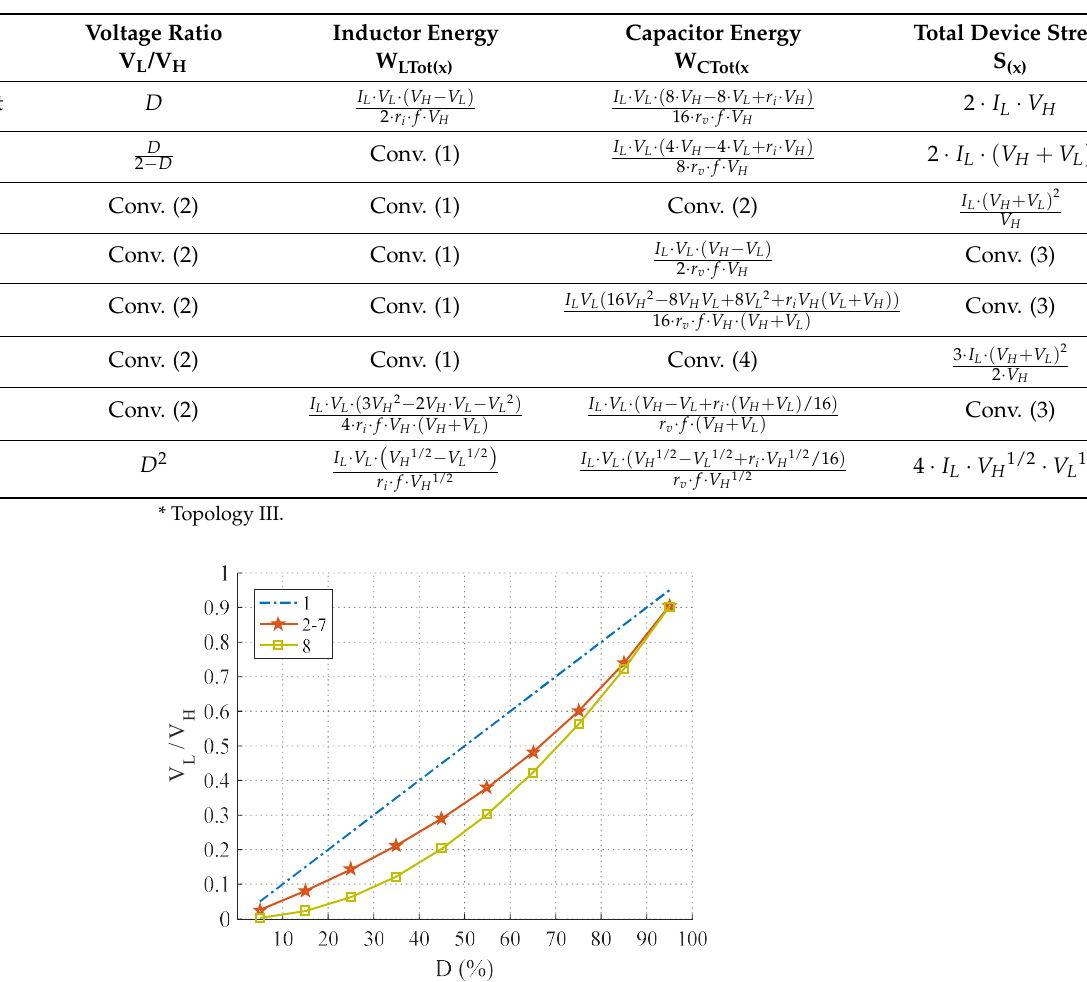
Table 1. The DC–DC converters used in the comparison.